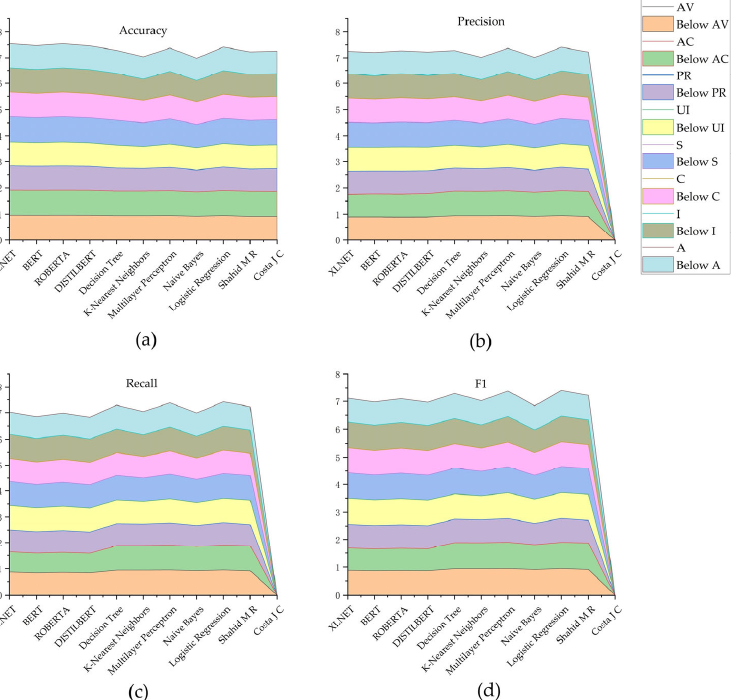
Figure 6. Performance comparison of XLNet with other algorithms on the CVSS v3.1 dataset. ( a ) Evaluation metric: accuracy; ( b ) evaluation metric: precision; ( c ) evaluation metric: recall; ( d ) eval ‐ uation metric: F1 ‐ score.